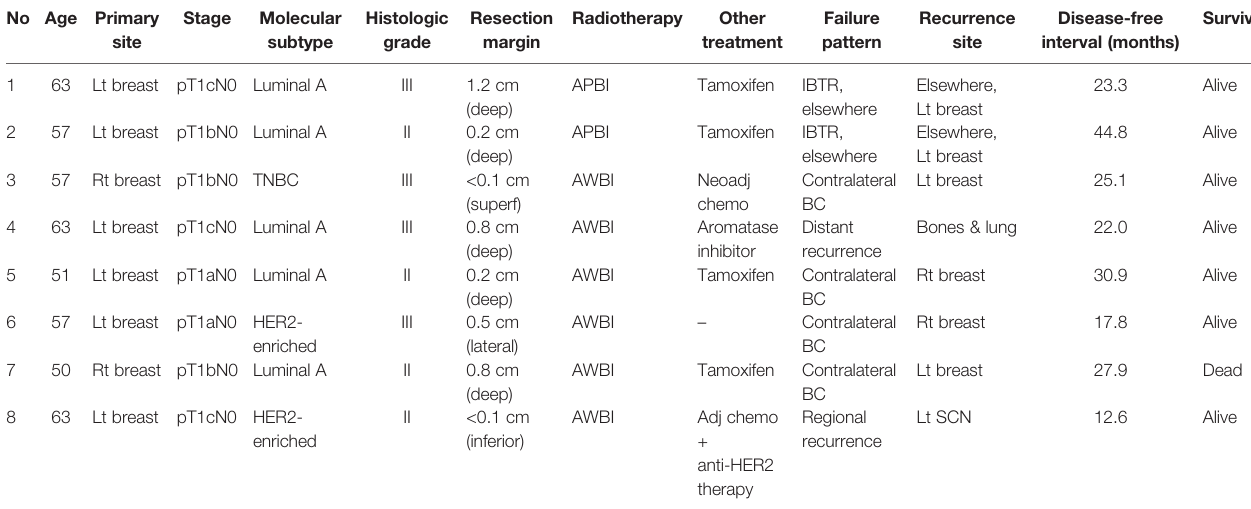
TABLE 3 | Detailed information on patients who experienced any event.